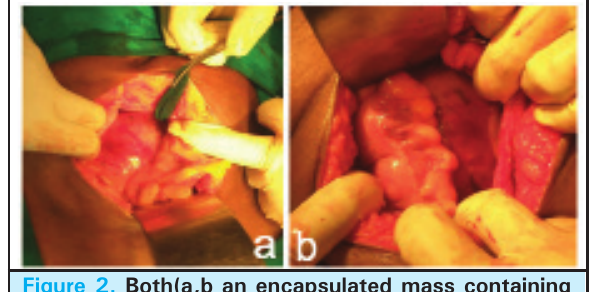
Figure 2. Both(a,b an encapsulated mass containing bowel loops and omentum occupying pouch of douglas with thickened